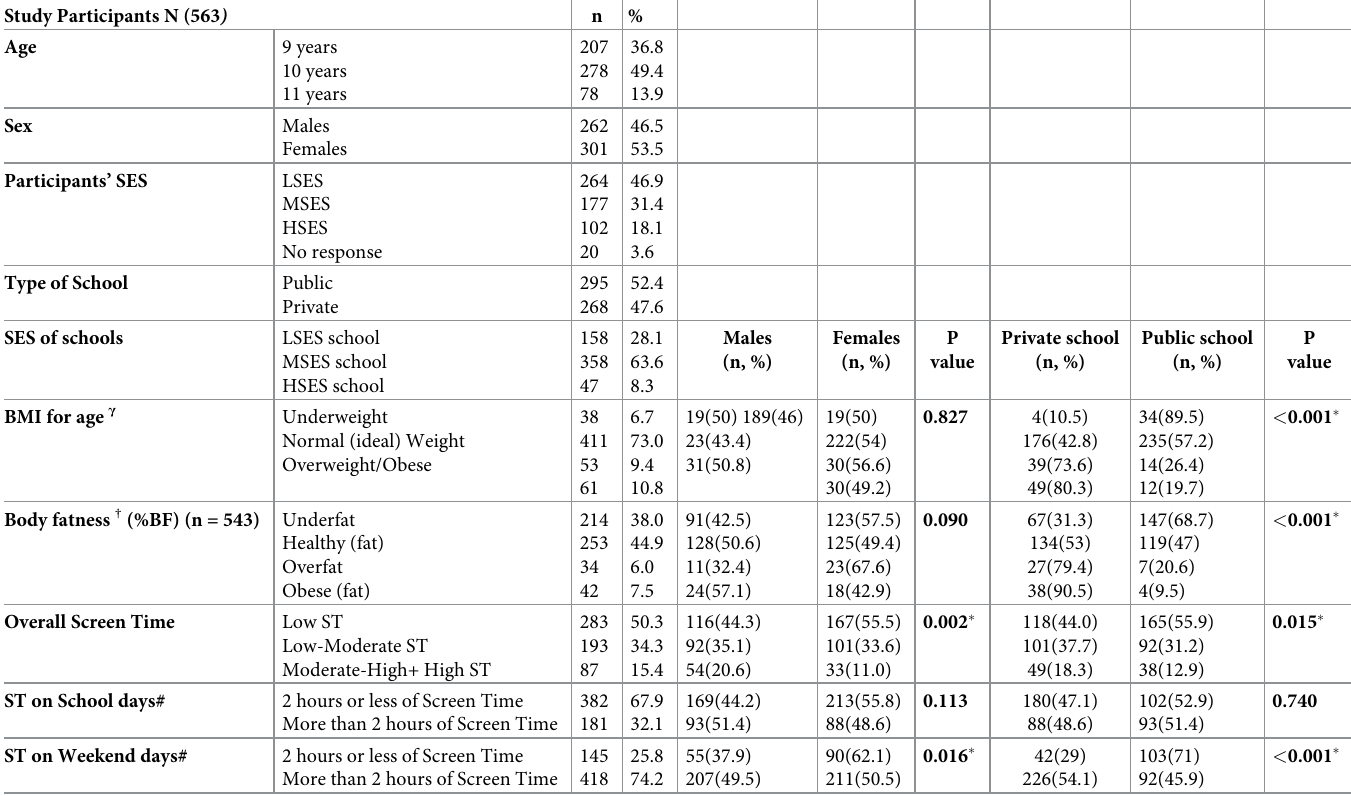
Table 2. Descriptive characteristics of study participants and schools.